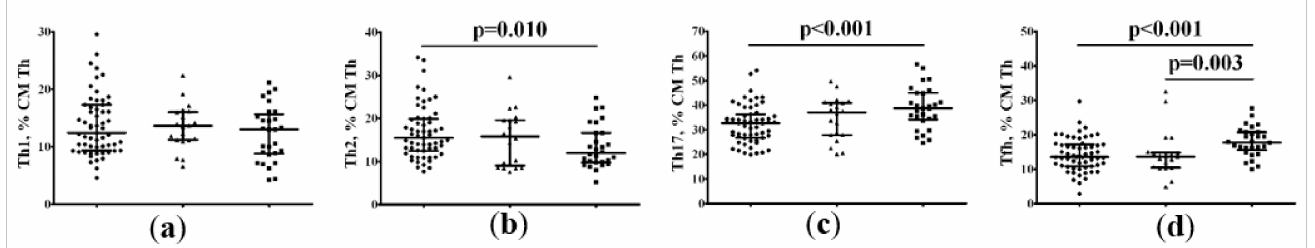
Figure 5. Imbalance of central memory CD3+CD4+ Th cell subsets in patients with COVID-19. Scatter plots show the relative count of the main “polarizes” Th cell subsets within the total central memory CD45RA − CD62L+ Th cells, including Th1 (CXCR5-CXCR3+CCR6-CCR4-) ( a ), Th2 (CXCR5-CXCR3- CCR6-CCR4+) ( b ), total Th17 (CXCR5-CCR6+) ( c ), and CXCR5-positive Tfh cells ( d ), respectively, in peripheral blood samples from patients with 25(OH)D > 11.4 ng/mL (black circles), patients with 25(OH)D ≤ 11.4 ng/mL (black triangles), and HC subjects (black squares). Numbers represent the percentage of the indicated Th cell subset among the total lymphocyte population. Each dot represents the individual subjects, and the horizontal bars represent the group medians and quartile ranges (Me [IQR 25;